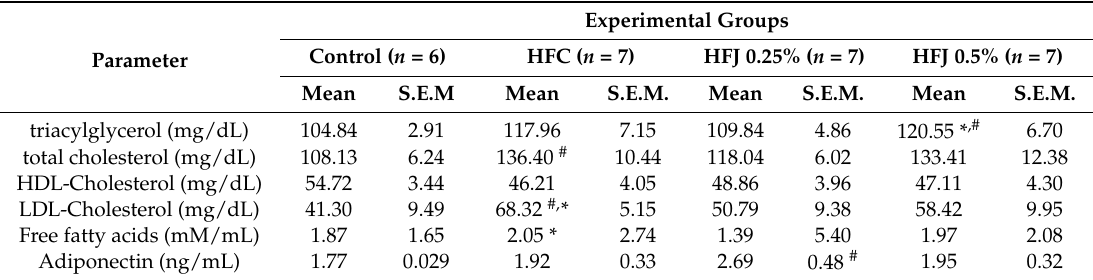
Table 2. Lipoproteins, triacylglycerol, free fatty acids and adiponectin analyses performed among the different experimental groups.